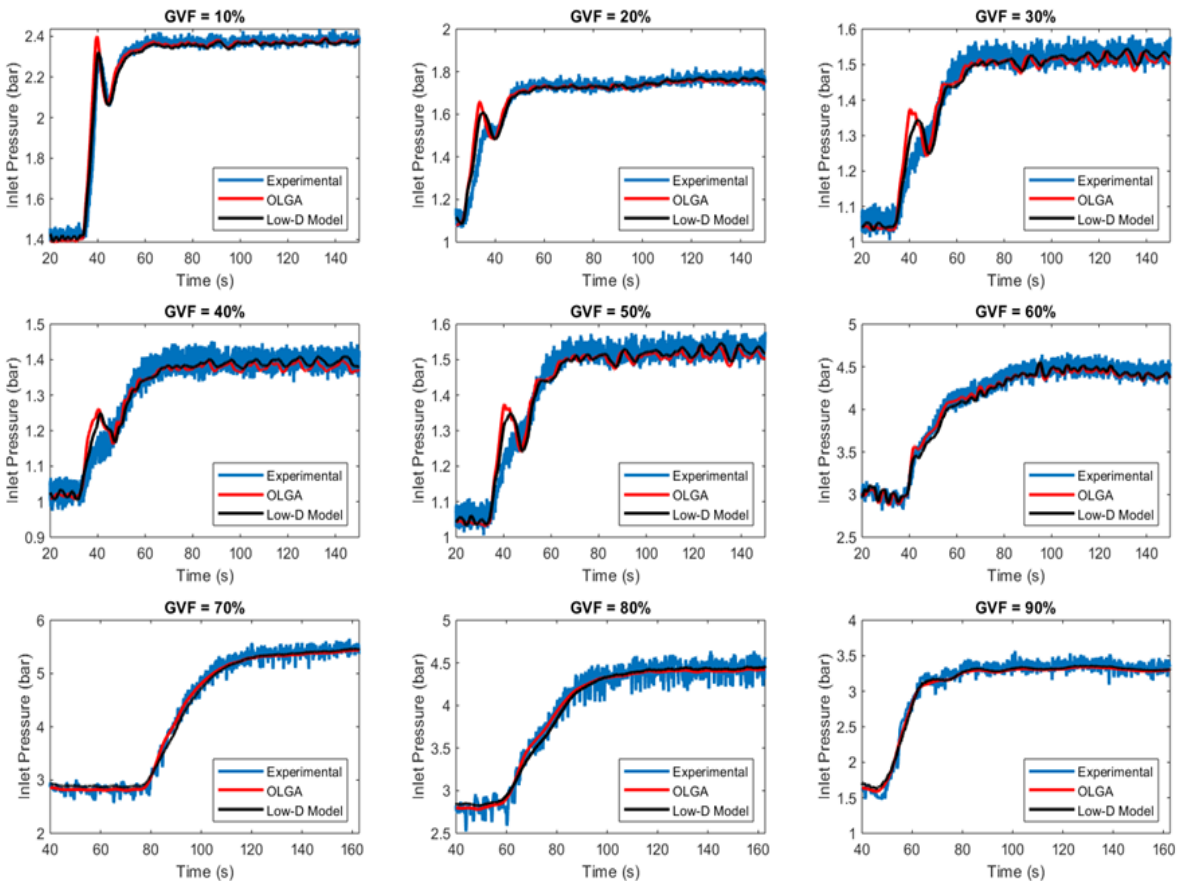
Figure 17. Pipeline dynamic response evaluation: slug flow (GVF = 10% to 60%), froth flow (GVF = 70% to 90%).